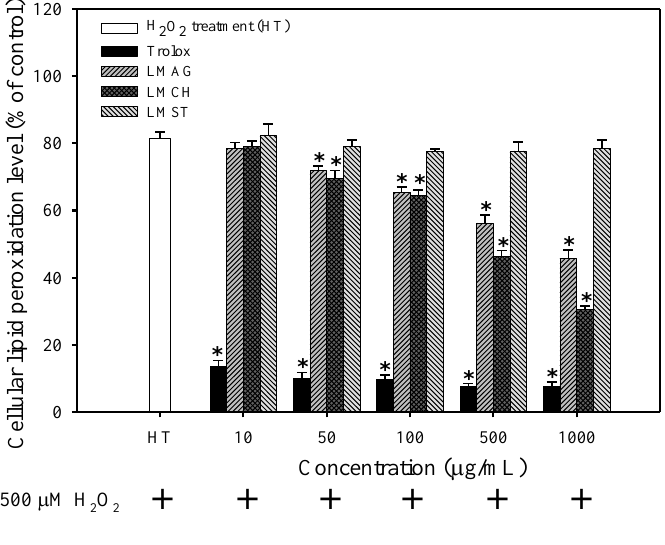
Figure 4. The effects of low-molecular-weight agar (LMAG), low-molecular-weight chitosan (LMCH), low-molecular-weight starch (LMST), and trolox on the cellular lipid peroxidation level of Hs68 cells after 24 h treatment with 500 μM H expressed as mean values ± S.D. of triplicate experiments. * p < 0.05 (treatment vs . HT); HT = H O 2 2